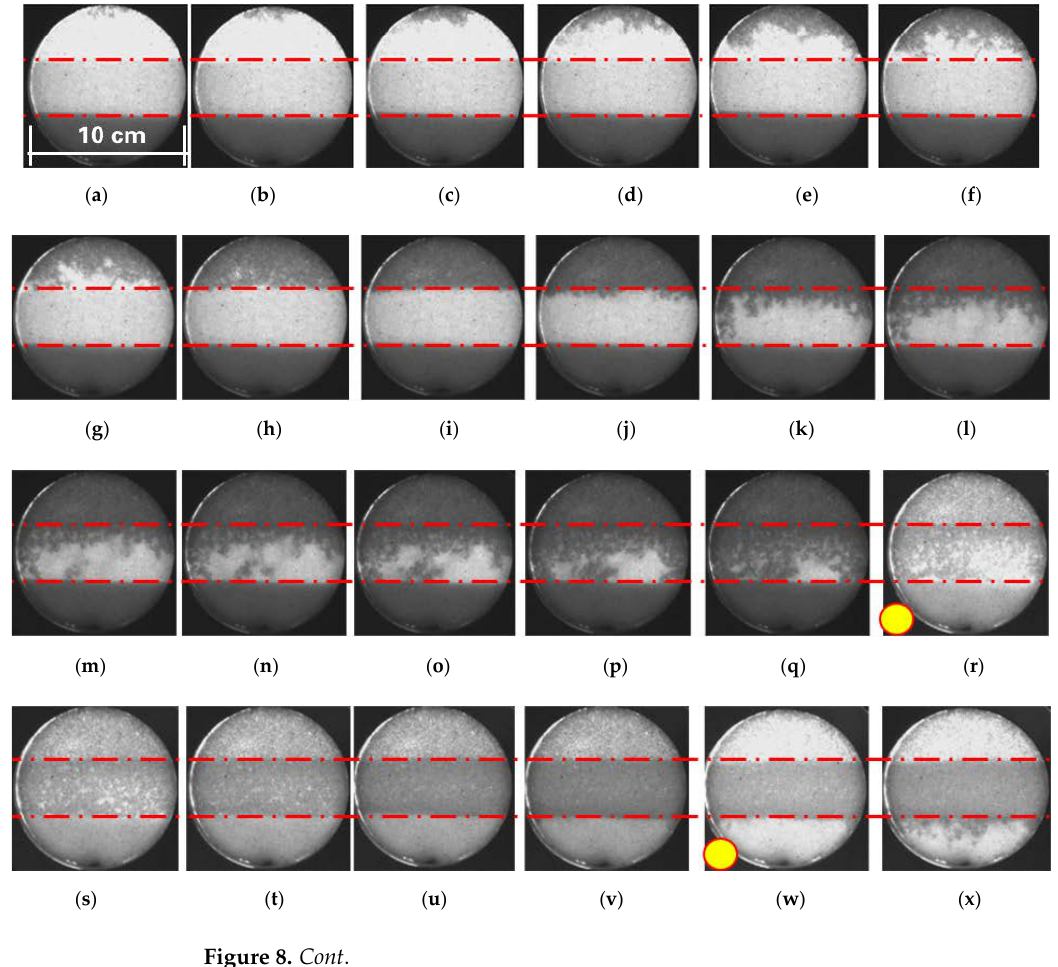
Figure 7. Relation between the recovery percent, gas–oil ratio and injection volume in the CO 2 in- jection process.